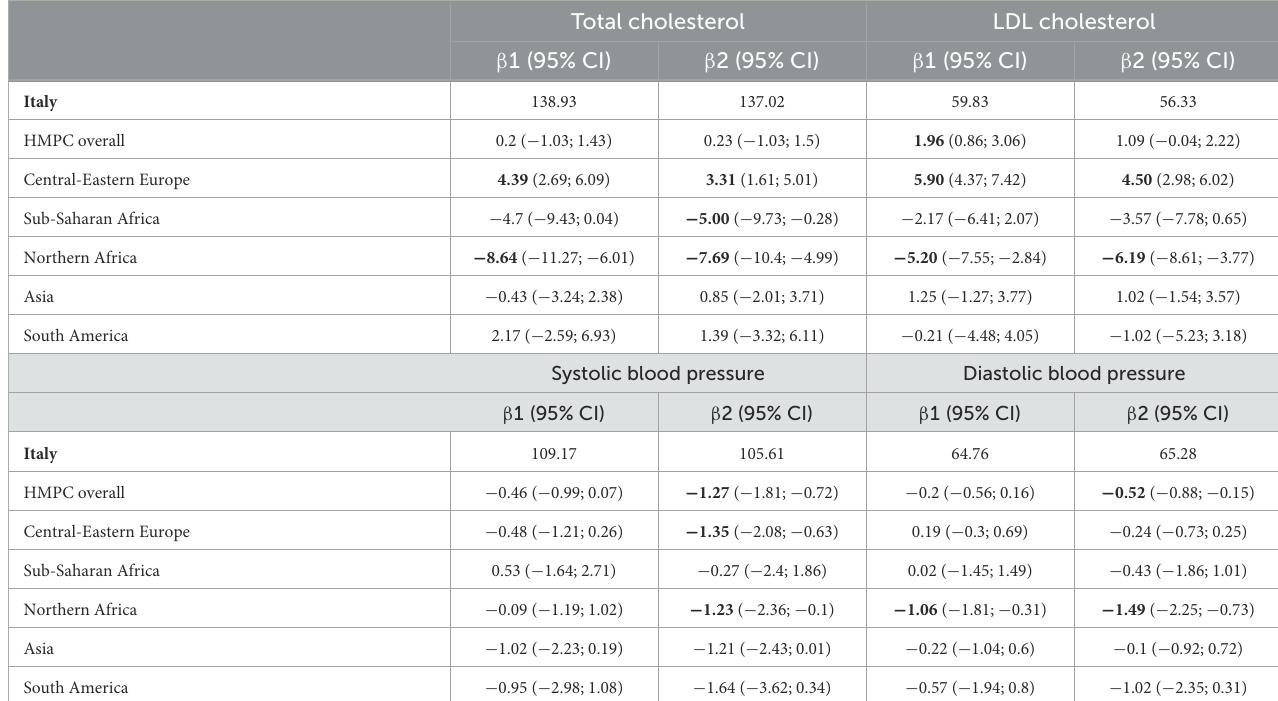
TABLE 2 β coefficients and 95% confidence intervals for the associations between immigrant status and total cholesterol, LDL cholesterol, systolic blood pressure and diastolic blood